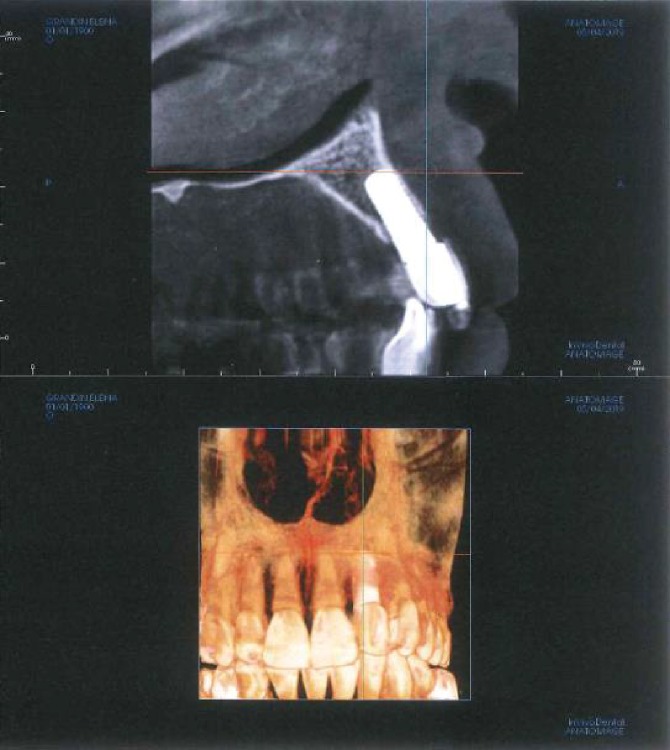
5-year follow-up.